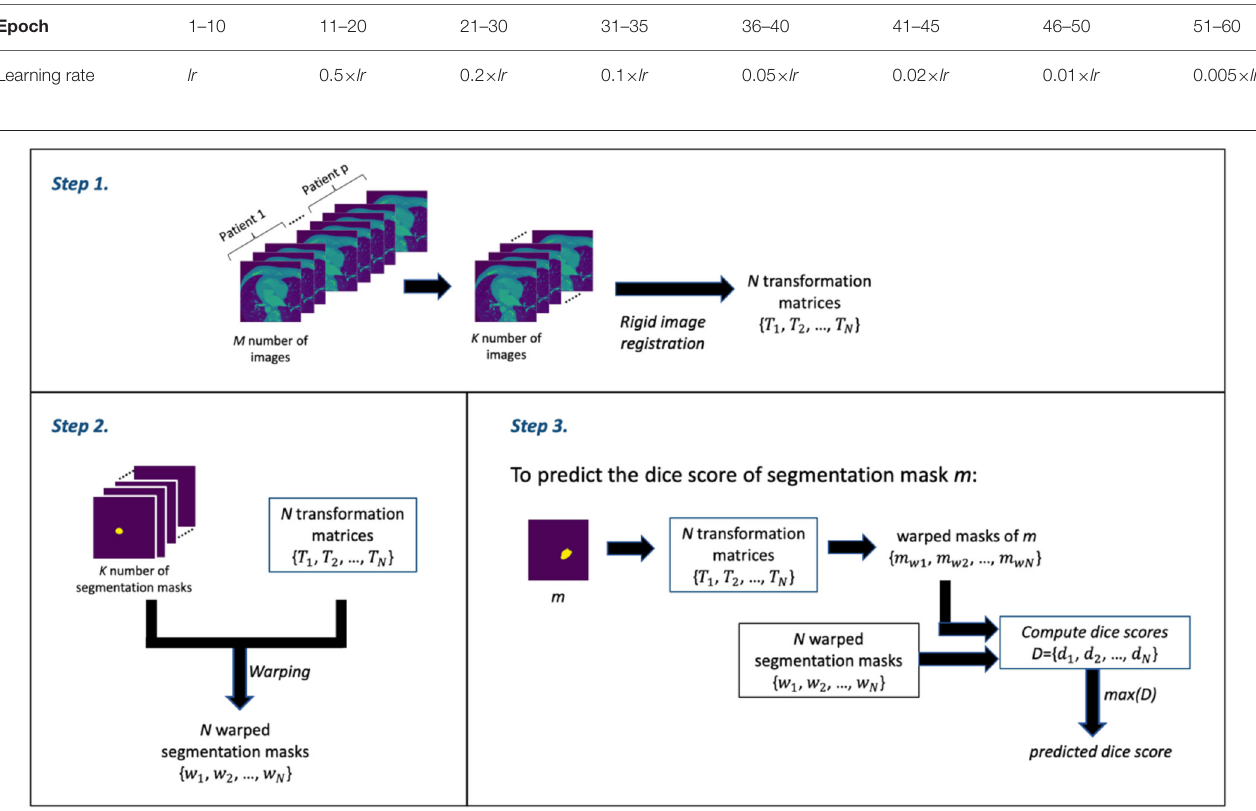
TABLE 7 | Learning rate adopted for training the UNet image segmentation model with lr = 1e-4.